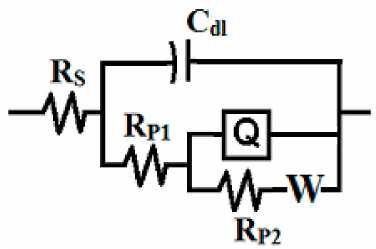
Figure 5. Equivalent circuit model employed to fit the impedance